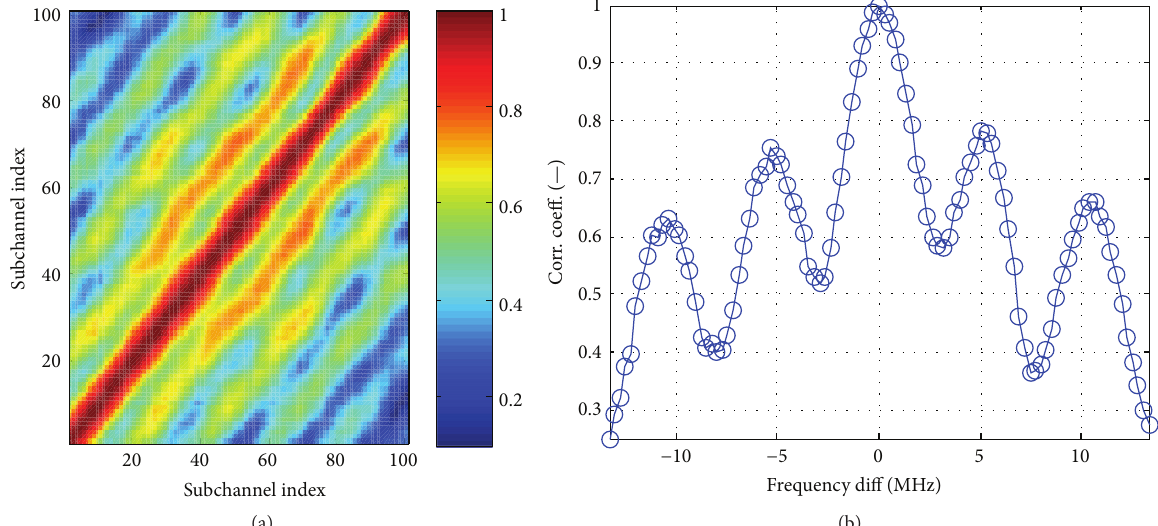
Figure 3: Cross-correlation between subchannels (a) and cross-correlation between the middle subchannel and the other subchannels (b).